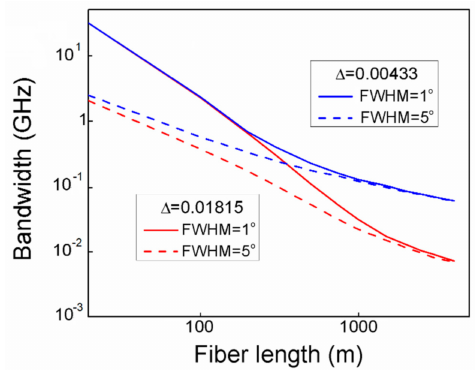
Figure 3. Bandwidth as a function of the optical fiber length for the Gaussian launch beams with (FWHM) z =0 = 1 ◦ and 5 ◦ for ∆ = 0.00433 ∆ = 0.01815.